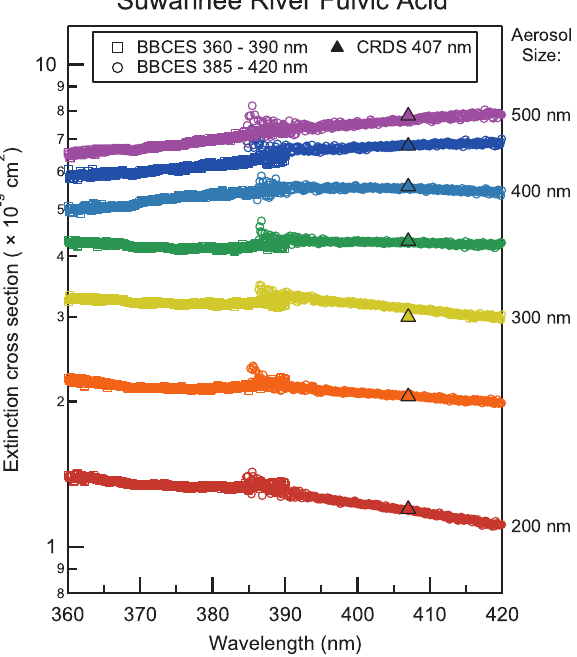
Fig. 9. Extinction cross sections as a function of wavelength for Suwannee River fulvic acid aerosol at 200–500nm diameter mea- sured with the BBCES 360–390nm, BBCES 385–420nm, and CRDS at λ = 407nm. Similarly to Fig. 7, these cross sections in- clude the population of singly, doubly, and triply charged particles at each DMA setpoint.